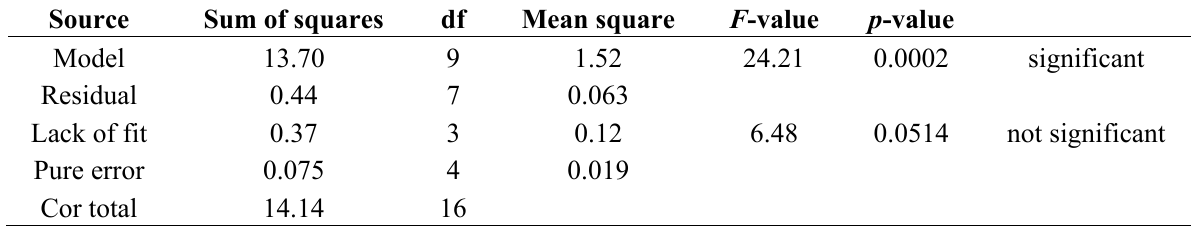
Table 3. Analysis of variance for fitted quadratic polynomial